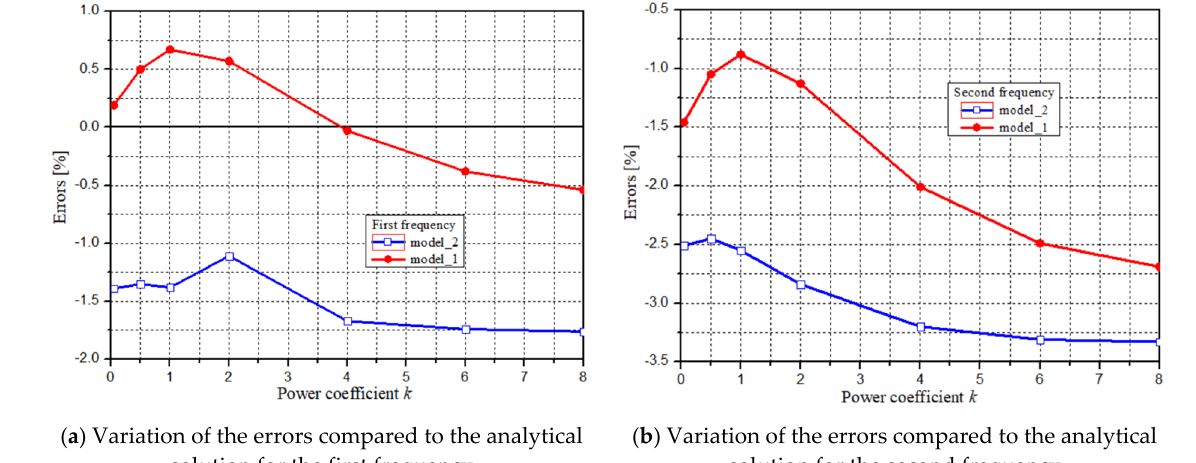
Figure 27. Error variation between analytical and numerical results, versus power coefficient k.